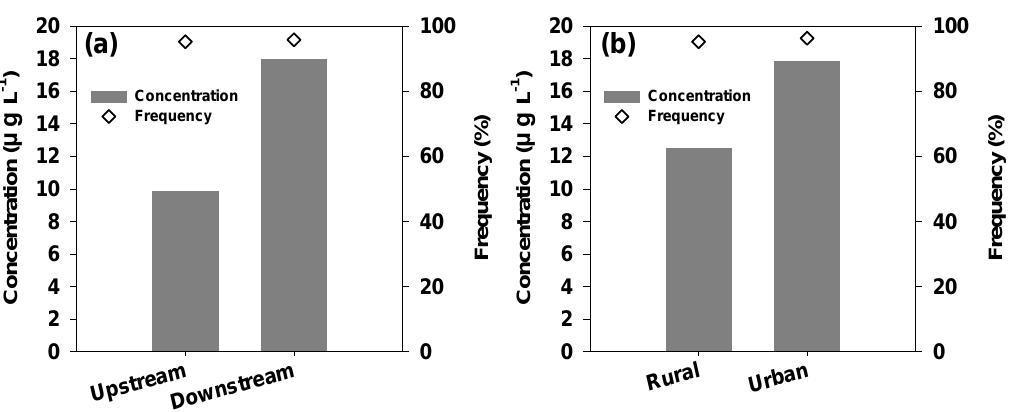
Figure 4. Concentration and detection frequency of the heavy metals in ( a ) up-and down streams of the wastewater treatment facilities (WTFs) and ( b ) rural and urban regions.